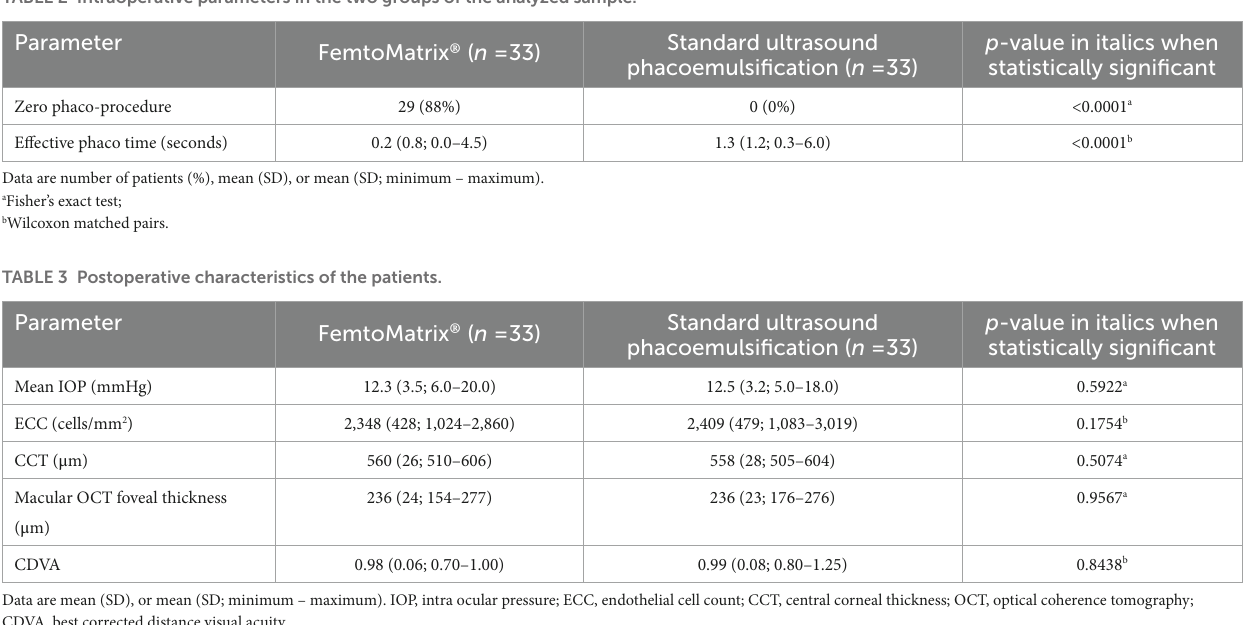
TABLE 2 Intraoperative parameters in the two groups of the analyzed sample.